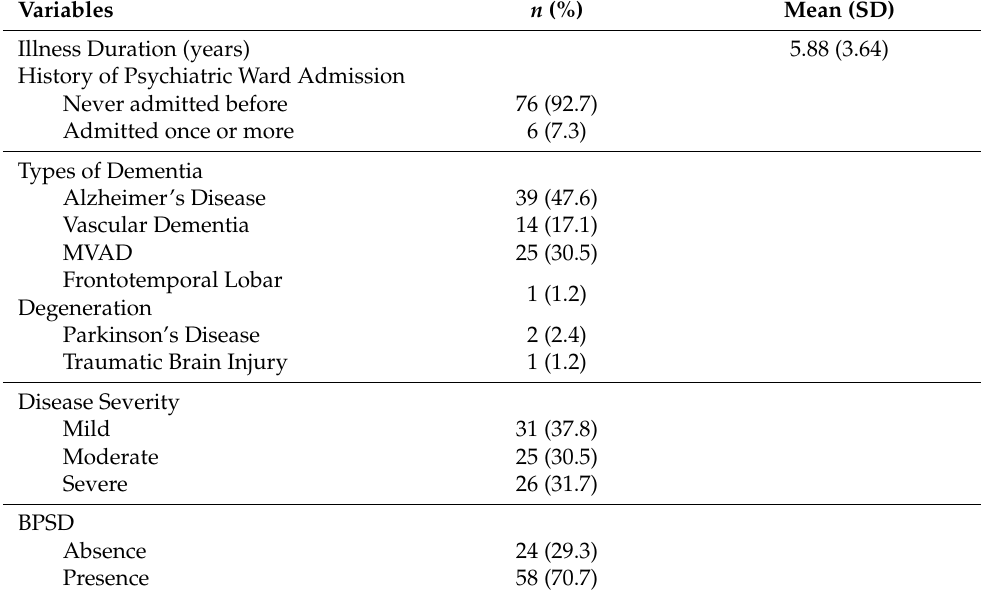
Table 3. Illness Characteristics of